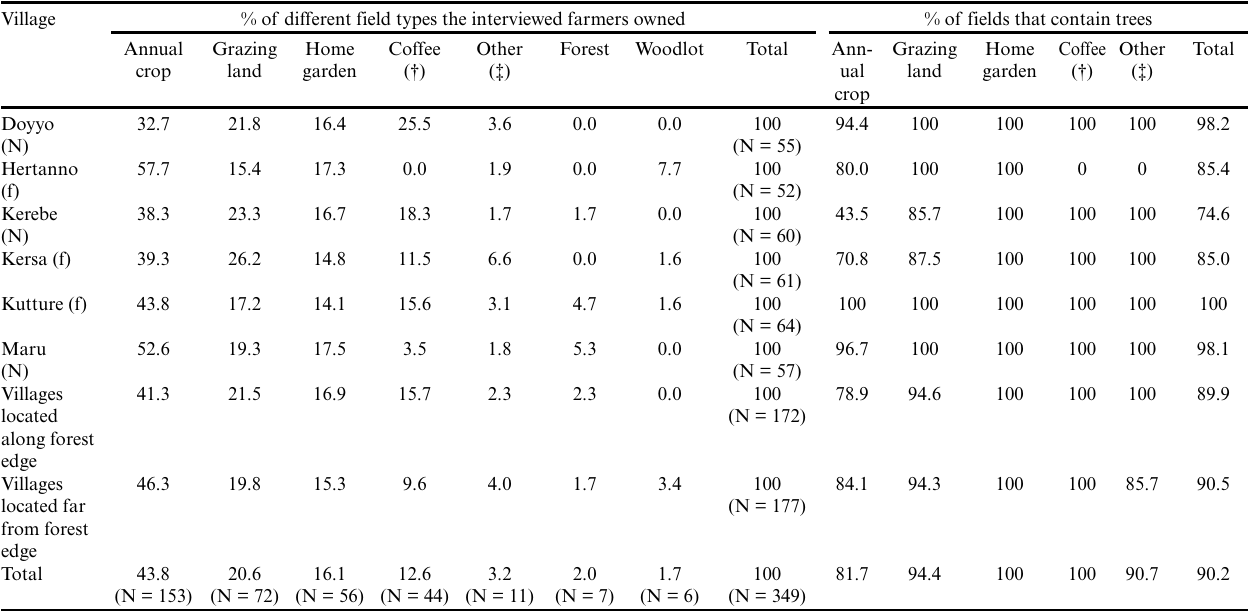
Table 1 . Percentages of different field types and percentages of fields that contain trees. Percentages relate to number of fields owned by the interviewed farmers. † Includes both cultivated and semimanaged forest coffee. ‡ Includes different land uses such as graveyard, mixed land uses, e.g., cereals and coffee, khat ( Catha edulis ), and sugarcane. f: Villages located far from forest edge. n: Villages located along forest edge. N: Total number of fields in a village or in a land use category, which the percentages represent. Village % of different field types the interviewed farmers